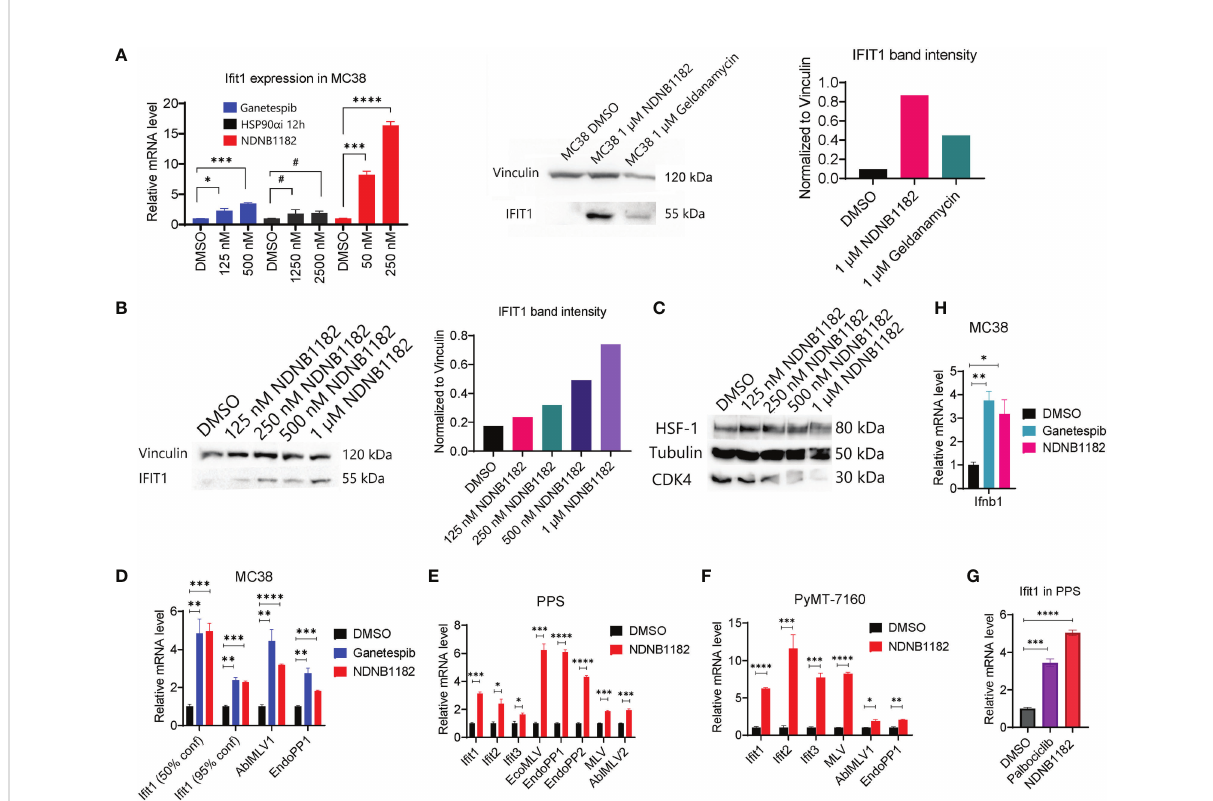
FIGURE 2 NDNB1182 upregulates IFIT and endogenous retroviral element expression. (A) qRT-PCR and western blot of I fi t1 expression in MC38 treated with DMSO, Ganetespib, NDNB1182, or Hsp90 a -i 12h, at the indicated concentrations for 6 hours. Cells were at 30% con fl uence when treated with the inhibitors. (B, C) Western blot of IFIT1, HSF1 and CDK4 in DU145 treated with DMSO or a concentration gradient of NDNB1182 for 12 hours. In (A, B) , the quanti fi cation of band intensities was from one representative result of three repeated experiments that showed consistent results. (D – F) qRT-PCR result of I fi t and ERV elements in MC38, PPS and PyMT-7160 treated with DMSO, Ganetespib (1µM) or NDNB1182 (1µM) for 6 hours. In (D) , MC38 con fl uence during the inhibitor treatment was indicated. (G) qRT-PCR result of I fi t1 expression in PPS treated with DMSO, NDNB1182 (1µM) and Palbociclib (2µM) for 6 hours. (H) qRT-PCR result of Ifnb1 expression in MC38 (50% con fl uence) treated with DMSO, Ganetespib (1µM) or NDNB1182 (1µM) for 6 hours. In (A, D – H) , data represent mean ± SEM, N=3. #, P>0.05; *P<0.05,